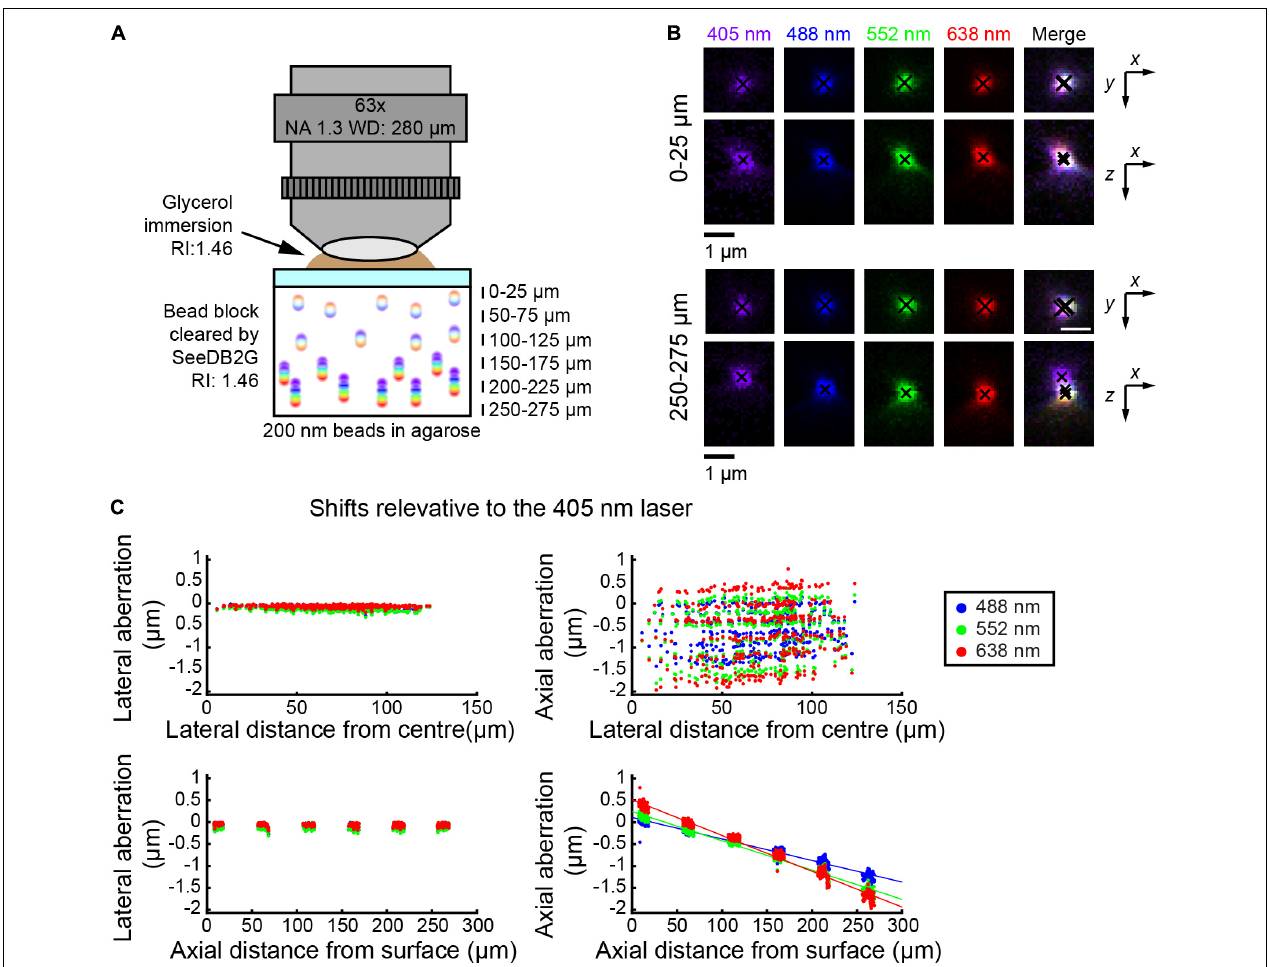
FIGURE 2 | Measuring chromatic aberrations with a high-numerical aperture (NA) objective lens (Leica 63 × ). (A) Fluorescent beads (200 nm) were embedded in agarose gel and then cleared with SeeDB2G (RI, 1.46). The agarose sample was mounted with a 0.17 mm thick coverslip. Glycerol (RI, 1.46) was used for immersion. (B) High-magnification images of fluorescence beads at representative depths (MIPs). Centroid positions are indicated by black crosses. (C) Lateral and axial chromatic aberrations at 488, 552, and 638 nm were determined as shifts relative to the 405 nm laser. Positive axial aberration values indicate that the bead